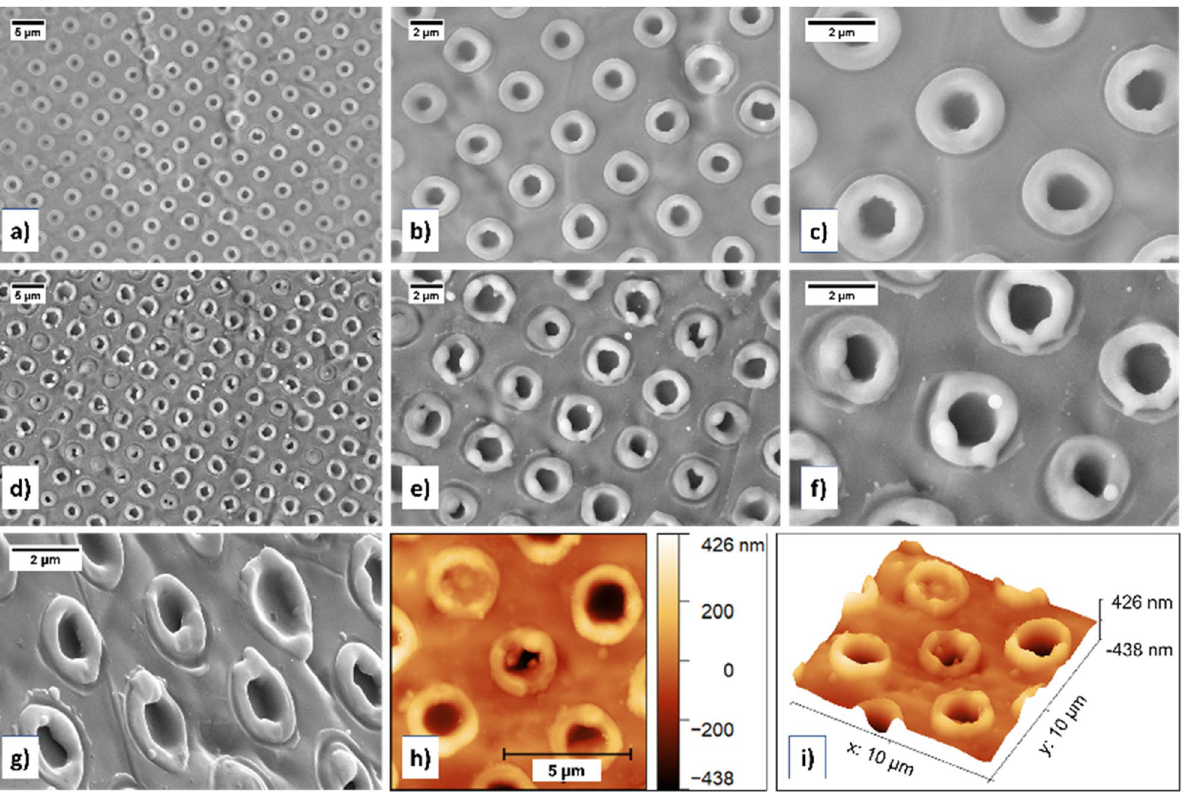
Figure 1. FESEM micrographs for DLIP on titanium in scCO 2 ( a – c ) and liquid CO 2 ( d – f ) at 100 bar pressure. Presence of ordered donut/ring pattern was observed for both environments, with only slight difference. Whereas in scCO 2 , the donut pattern seemed smooth, in case of liquid CO 2 , the donut pattern consisted of melt deposits on top of the donut rings that were sometimes spherical. ( g ) Tilt-view FESEM micrograph revealed donut rings formed by DLIP in scCO 2 protrude out of the target plane and contain a crevice in the centre. Atomic force microscopy (AFM) image showing topographical ( g ) 2D and ( h ) 3D images of donut ring pattern on